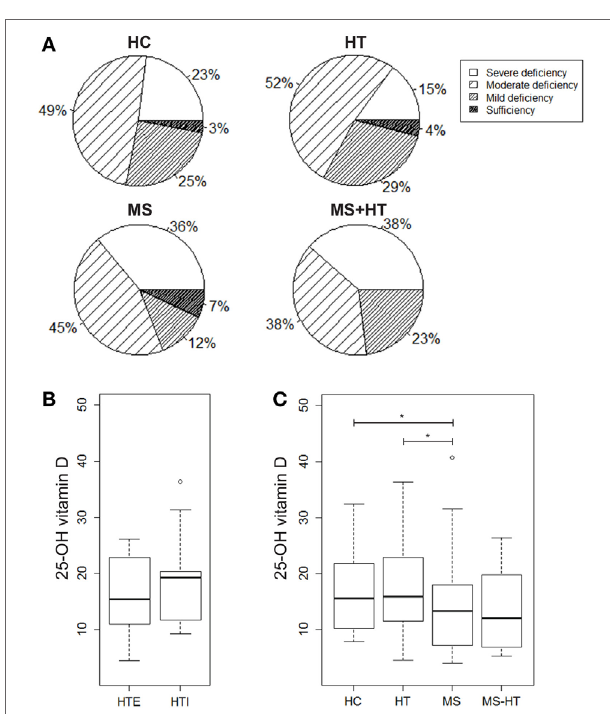
FigUre 4 | (a) Percentage of individuals for each group showing severe 25-OH vitamin D deficiency ( < 10 ng/mL), moderate deficiency (10–19.9 ng/ mL), mild deficiency (20–29.9 ng/mL), or sufficiency ( > 30 ng/mL). 25-OH vitamin D serum levels in (B) hypothyroid (HTI) and HTE separately and in (c) healthy control (HC), Hashimoto’s thyroiditis (HT), multiple sclerosis (MS), and MS + HT. Differences between groups were evaluated by the Mann– Whitney U test.